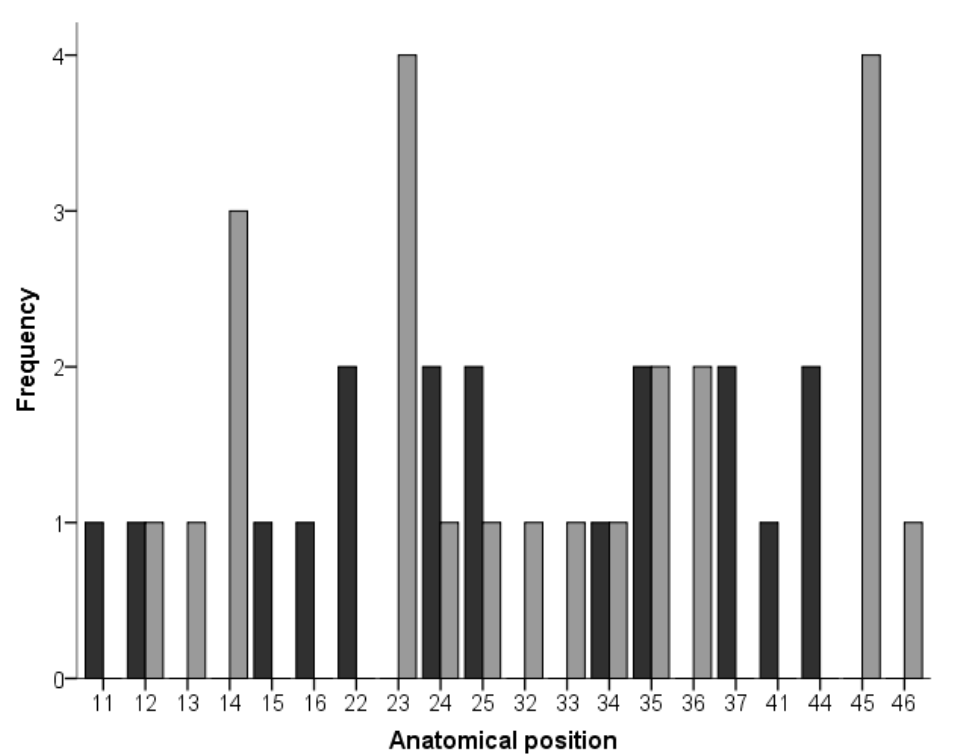
Figure 1. The location of the implants in the test (black) and control (grey) groups. Implant position was defined following the FDI tooth numbering system.